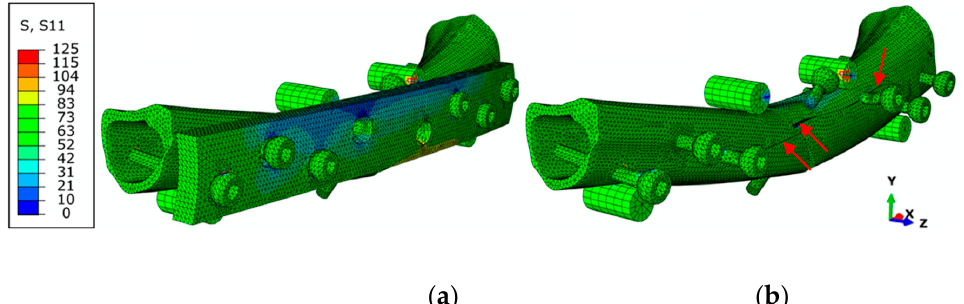
 ) (in MPa) of the FPB finite element model showing ( a ) the DCP Figure 14. Normal stress field ( Figure 14. Normal stress field ( σ xx ) (in MPa) of the FPB finite element model showing ( a ) the DCP xx plate and ( b ) when hiding the DCP plate (red arrows show bone cracks in bone). plate and ( b ) when hiding the DCP plate (red arrows show bone cracks in